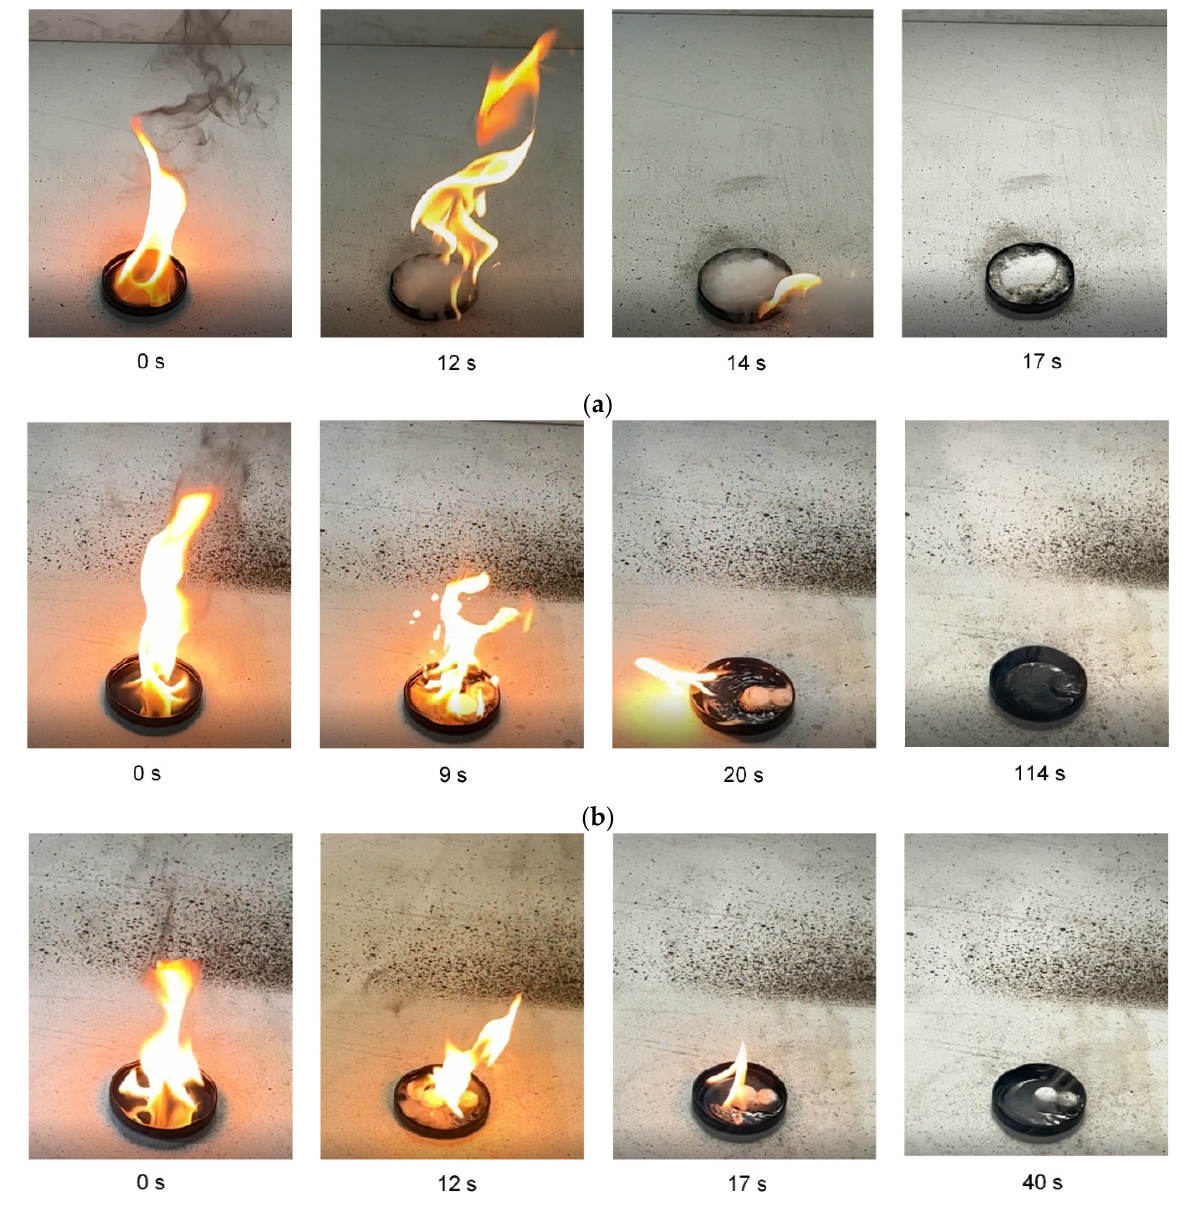
Figure 3. Images of Diesel fuel fire suppression ( V 0 ≈ 3 mL) with the help of carbon dioxide hydrate in the forms of ( a )) powder, m g ≈ 4 g; ( b )) tablets, m g ≈ 1.07 g; ( c )) spheres, m g ≈ 1.42 g ( d f ≈ 65 mm, S f ≈ 33 cm 2 ).